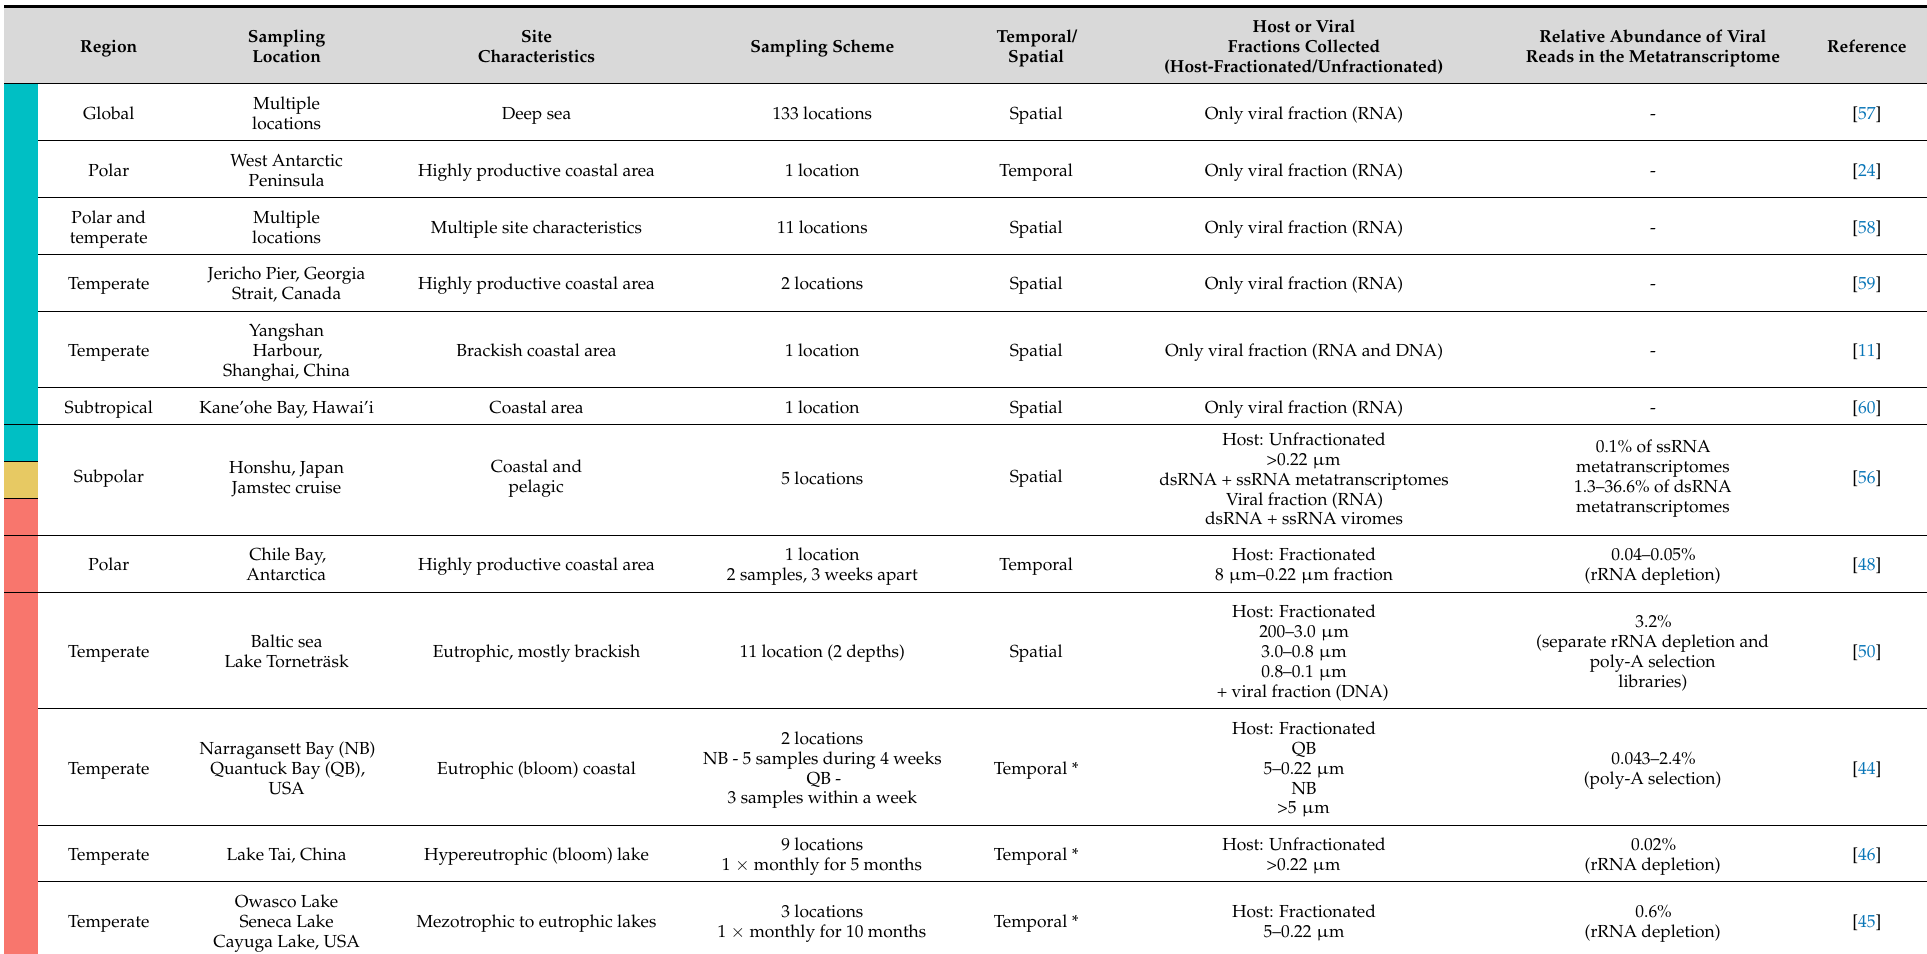
Table 2. Basic geographic, ecosystem, and sampling information about the aquatic metaviromic (turquoise) studies, metatranscriptomic (coral) studies, and dsRNA sequencing (yellow) reviewed in this paper. Asterisk * denotes a temporal study in multiple